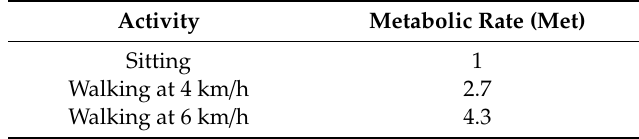
Table 5. Metabolic rate of test person during di ff erent levels of